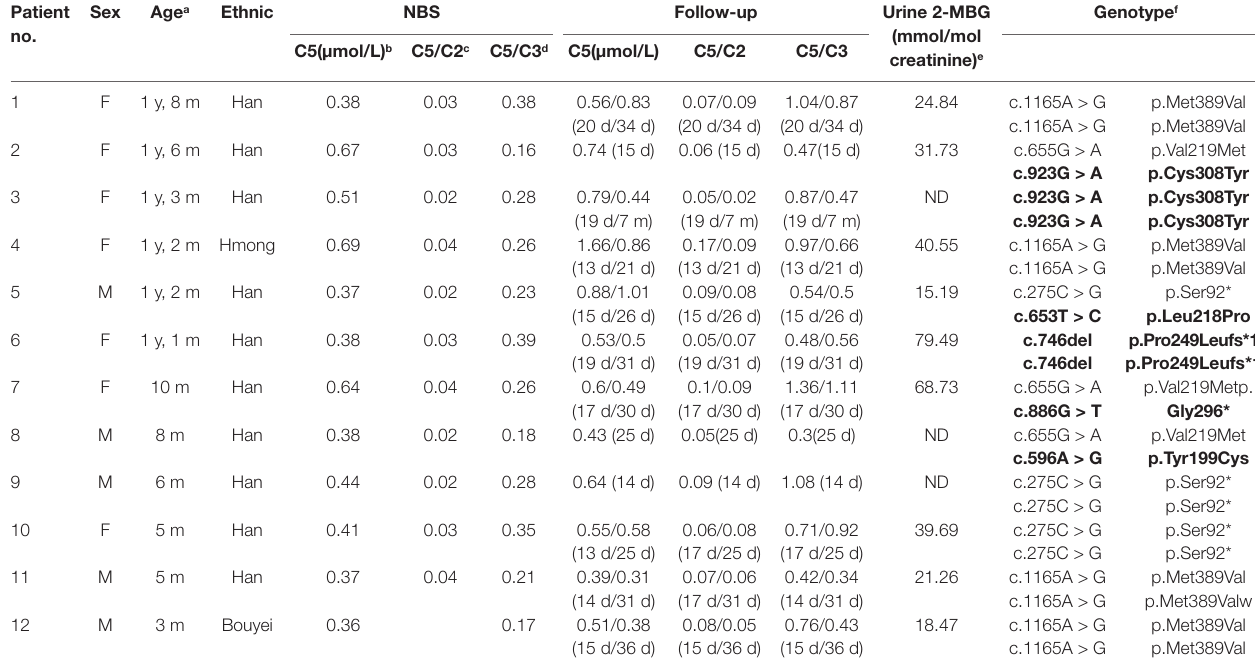
TABLE 1 | Biochemical phenotype and genotype of twelve newborns with SBCADD. Patient